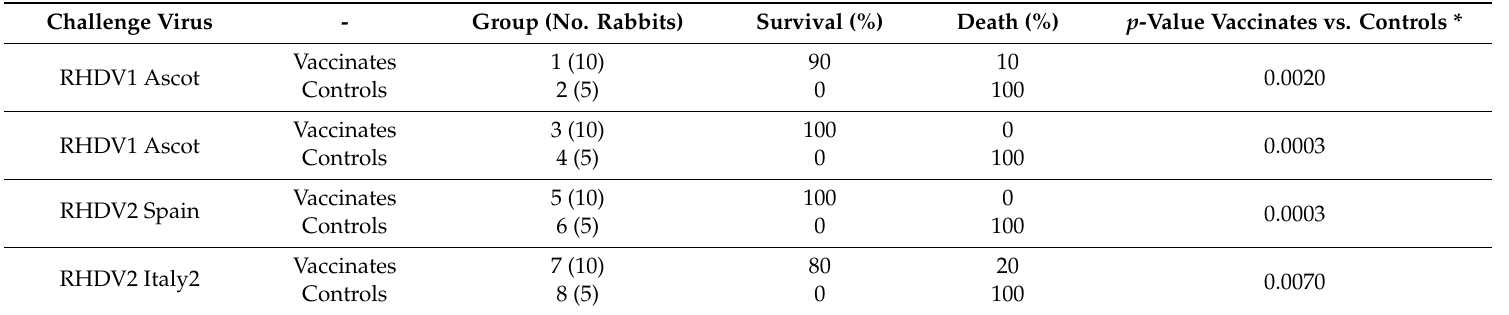
Table 8. Summary of mortality after RHDV challenge in NZW rabbits.